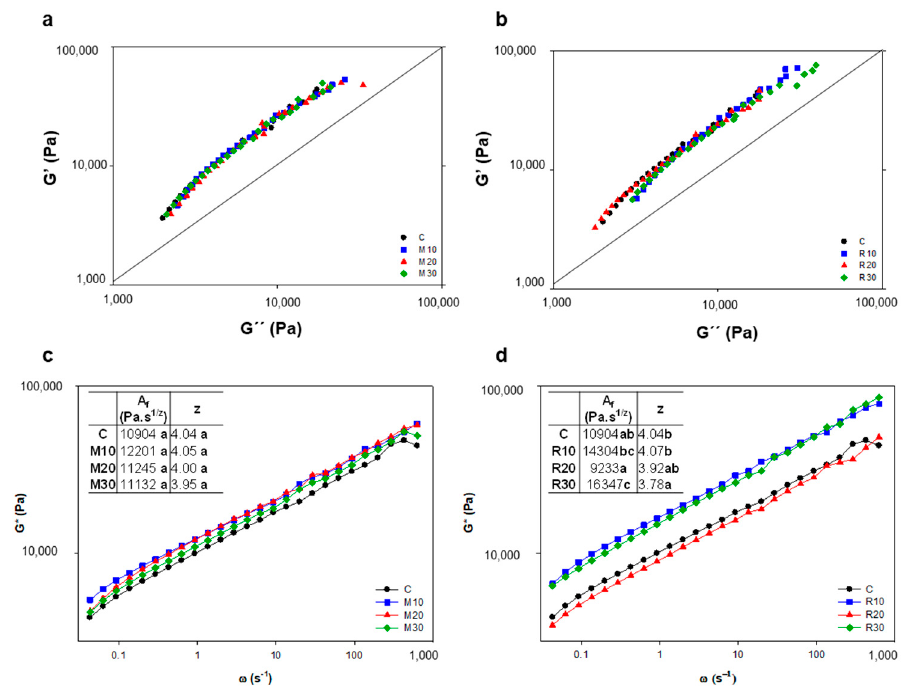
Figure 3. Small amplitude oscillatory rheology of dough. Elastic modulus (G ′ ) as a function of viscous modulus (G ″ ) of wheat flour dough with: Misak ( a ) and Rumbo ( b ) lupine flours. Complex modulus (G*) as a function of ω of wheat flour dough with Misak ( c ) or Rumbo ( d ) lupine flours. C: wheat dough. Wheat flour complemented with Misak: 10% (M10), 20% (M20) and 30% (M30); and with Rumbo: 10% (R10), 20% (R20) and 30% (R30). Different letters in the same parameters indicate a significant difference ( p < 0.05).